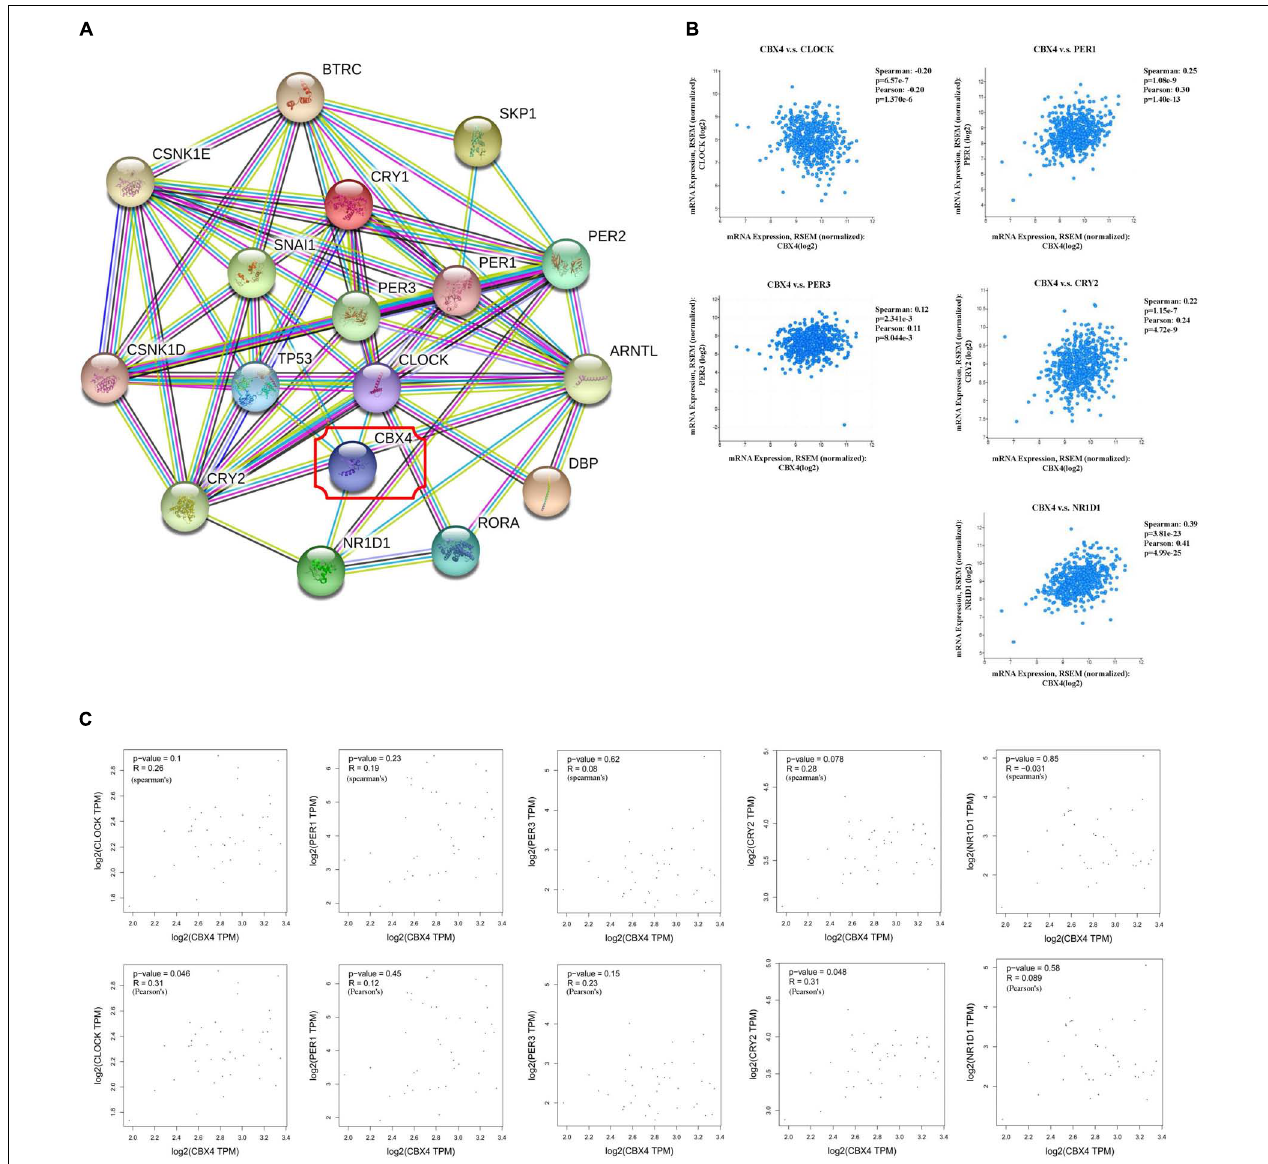
FIGURE 2 | CBX4 Expression Correlates with That of Circadian Clock Genes in Colon Adenocarcinoma. (A) The associated PPI network of CBX4 pertaining to Homo sapiens was constructed by STRING v11.0 based on a highest confidence coefficient defined by a minimum interaction score > 0.9. 16 of STRING interactants for CBX4 were summarized, PPI enrichment p-value: < 1.0 × 10 − 16 . (B) The correlations between CBX4 and the circadian clock genes including CLOCK, PER1, PER3, CRY2, NR1D1 in COAD samples were determined by cBioportal. Levels of the mRNA expression were normalized in Log2 RSEM. The correlation coefficients and the significance were indicated. (C) The correlations between CBX4 and the circadian genes in normal colon tissue samples were examined by GEPIA database. The gene expression levels were shown in TPM. Spearman’s (upper) and Pearson’s (lower) R and the significance were